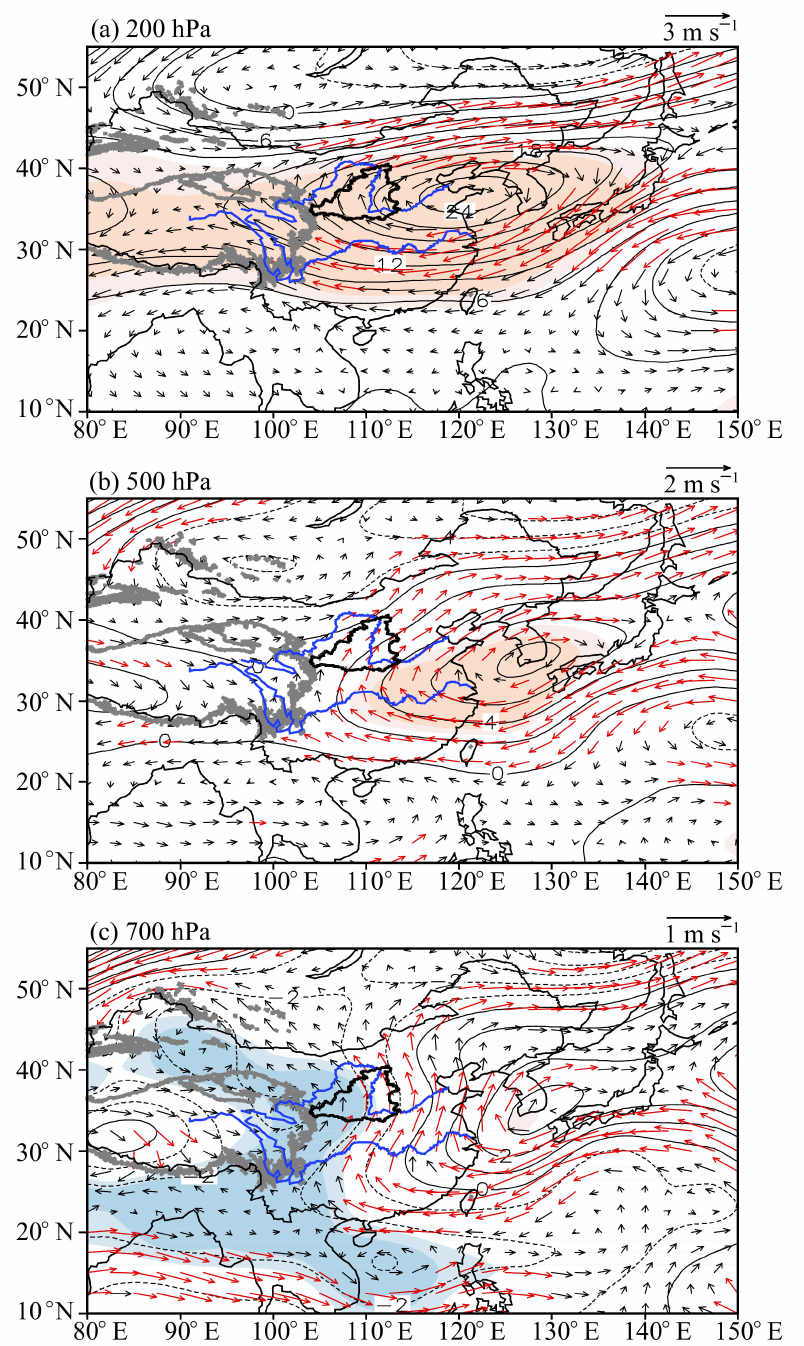
Figure 5. As in Figure 2, but for the anomalies of September geopotential heights and winds obtained by regressing upon the July–August YGP SM